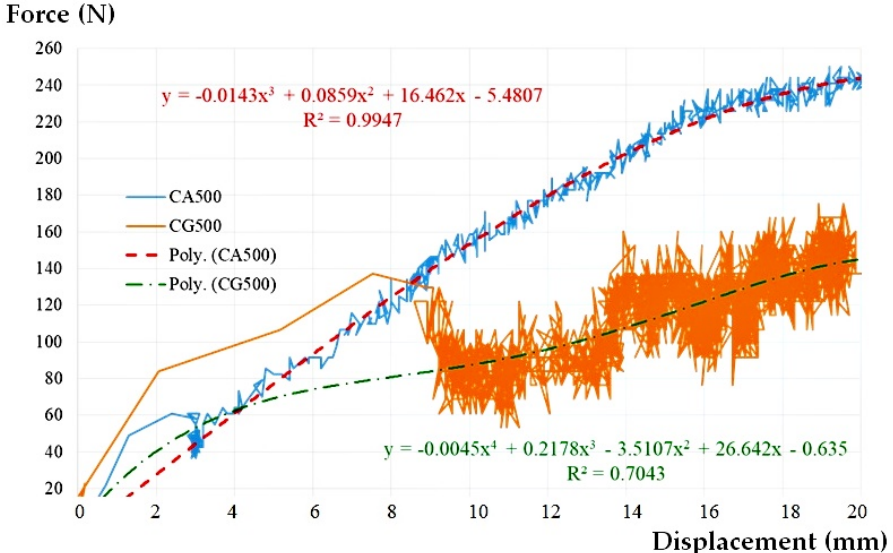
Figure 6. The graph load-displacement curve approximation and cases CG500 and CA500. Table 2. Comparing experimental results for scenarios CG500 and CA500.